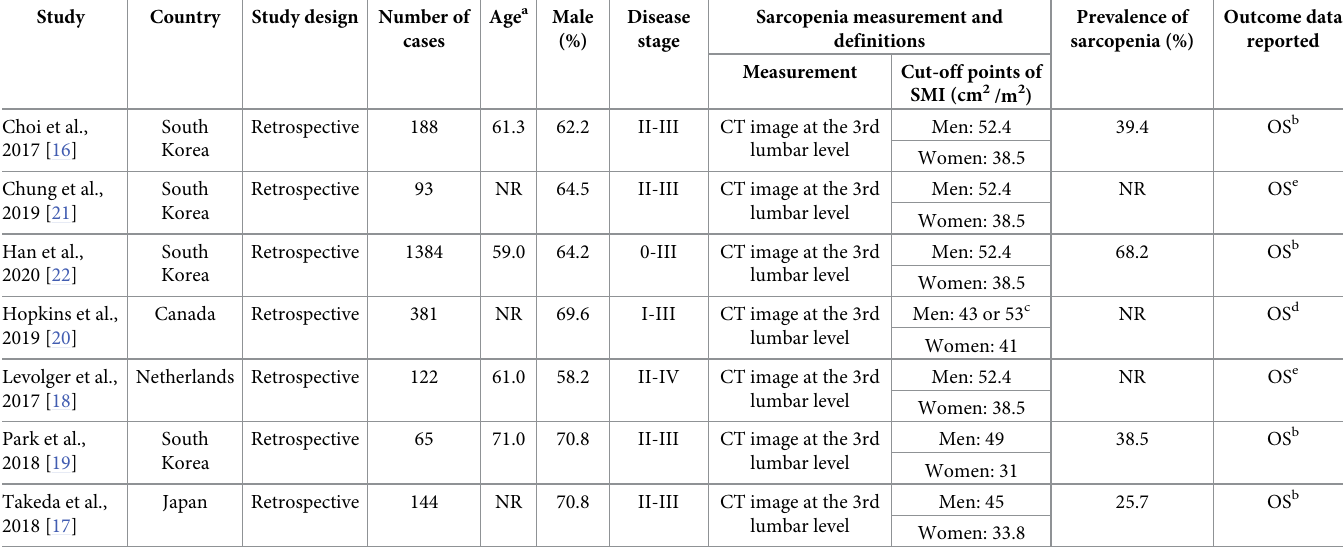
Table 1. Study characteristics of included studies.